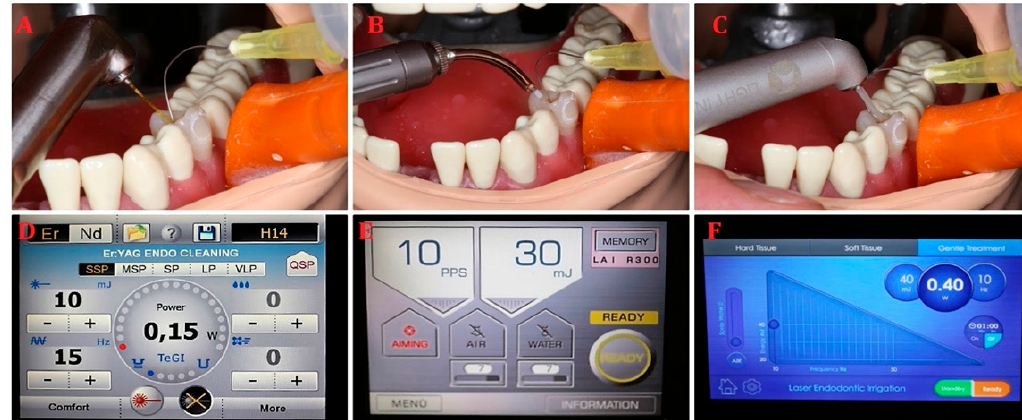
Figure 6. Root canal irrigation with Er:YAG lasers: ( A , D ) LightWalker; ( B , E ) AdvErL Evo; ( C , F ) LiteTouch.